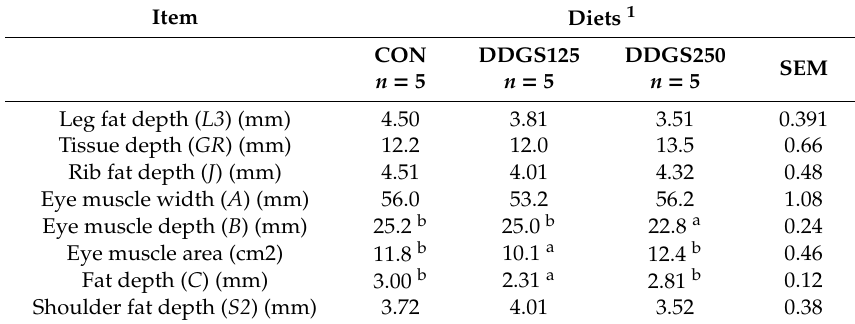
Table 5. E ff ects of feeding dried distillers’ grains with solubles (DDGS) on carcass leaner dimensions of growing Awassi lambs.